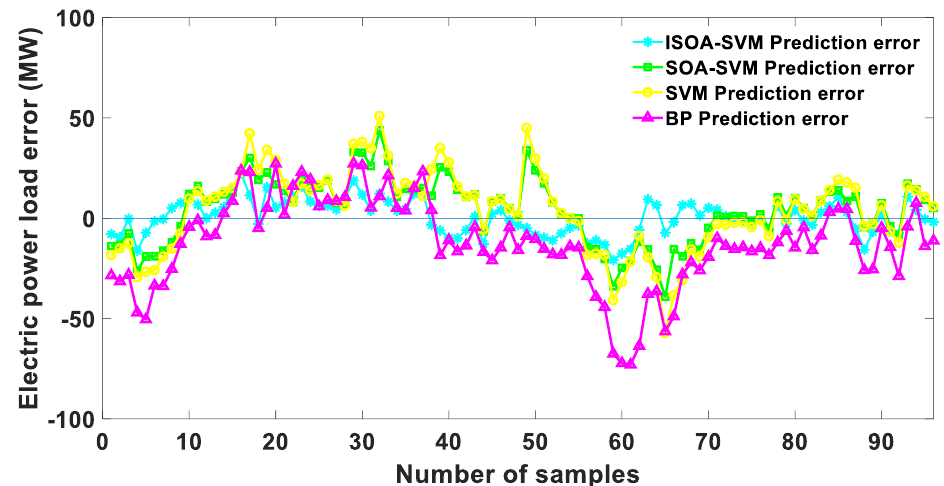
Figure 2. Power load forecasting results of four models for Case 1.